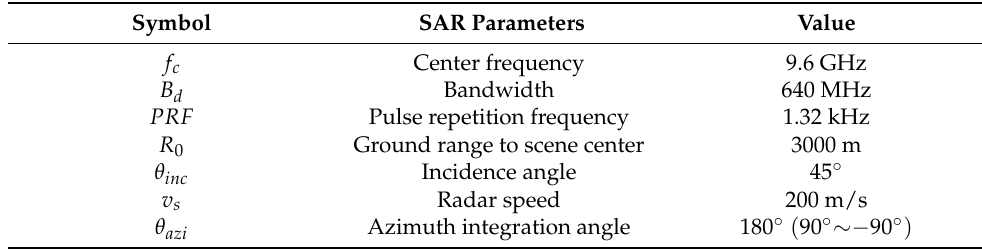
Table 1. SAR Simulation